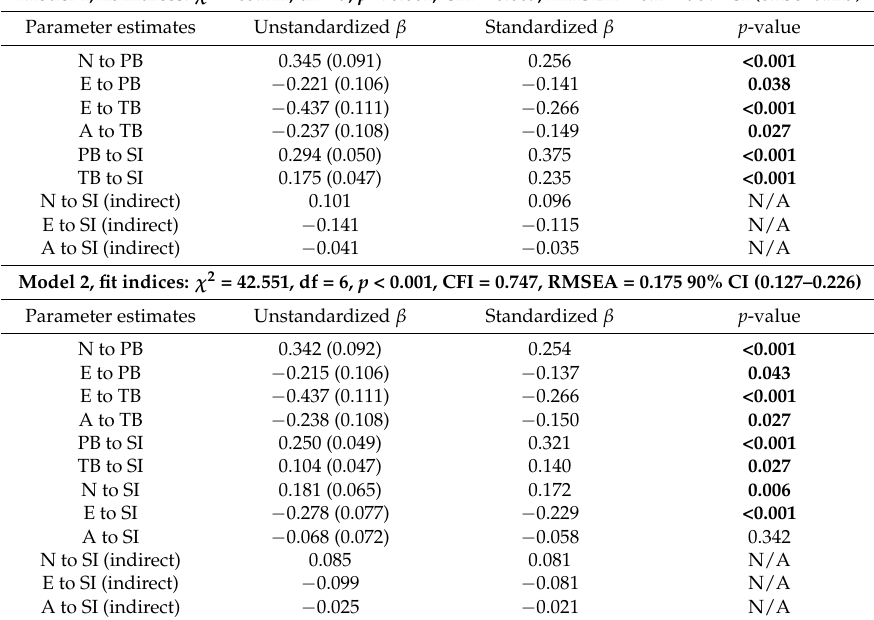
Table 2. Estimated unstandardized (with standard errors) and standardized parameters for the regression weights, as well as fit indices, for the two models with PB and TB as mediators in the relationship between FFM variables and